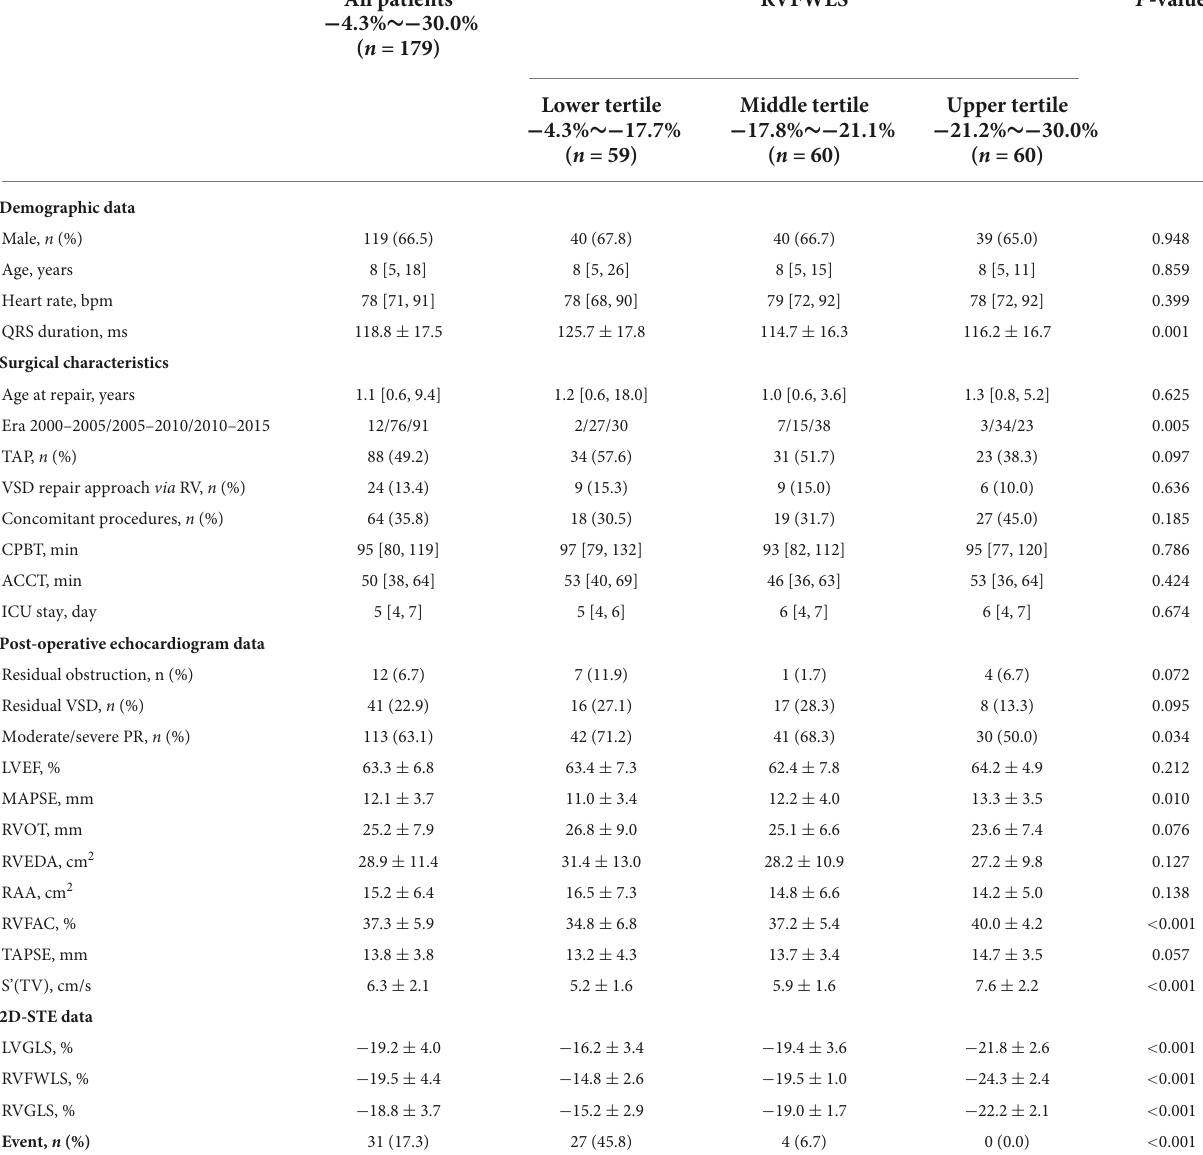
TABLE 1 Post-operative baseline characteristics of patients with r-TOF according to tertiles of RVFWLS. All patients − 4.3% ∼−